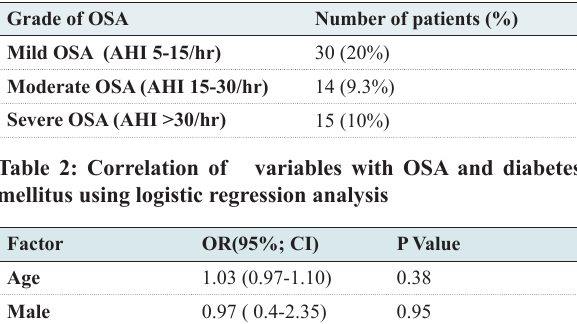
Table 1: Obstructive sleep apnea in diabetic patients (n=59)